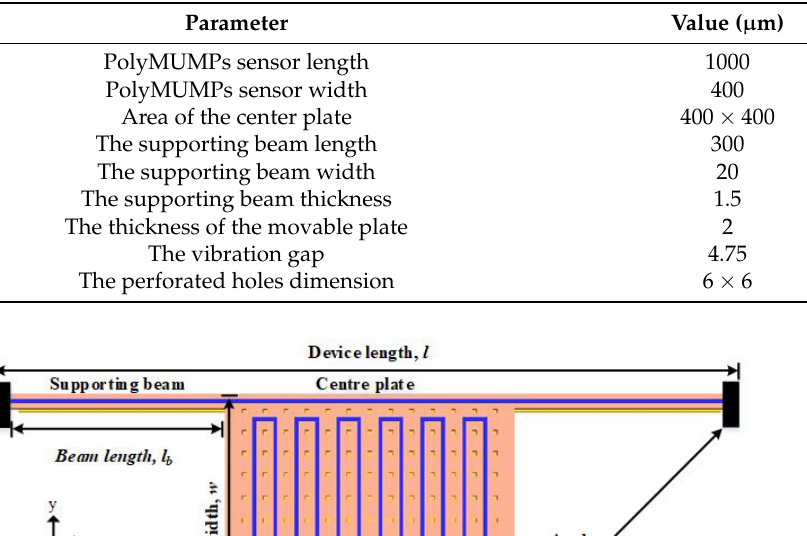
Table 1. The PolyMUMPs sensor’s dimensions.